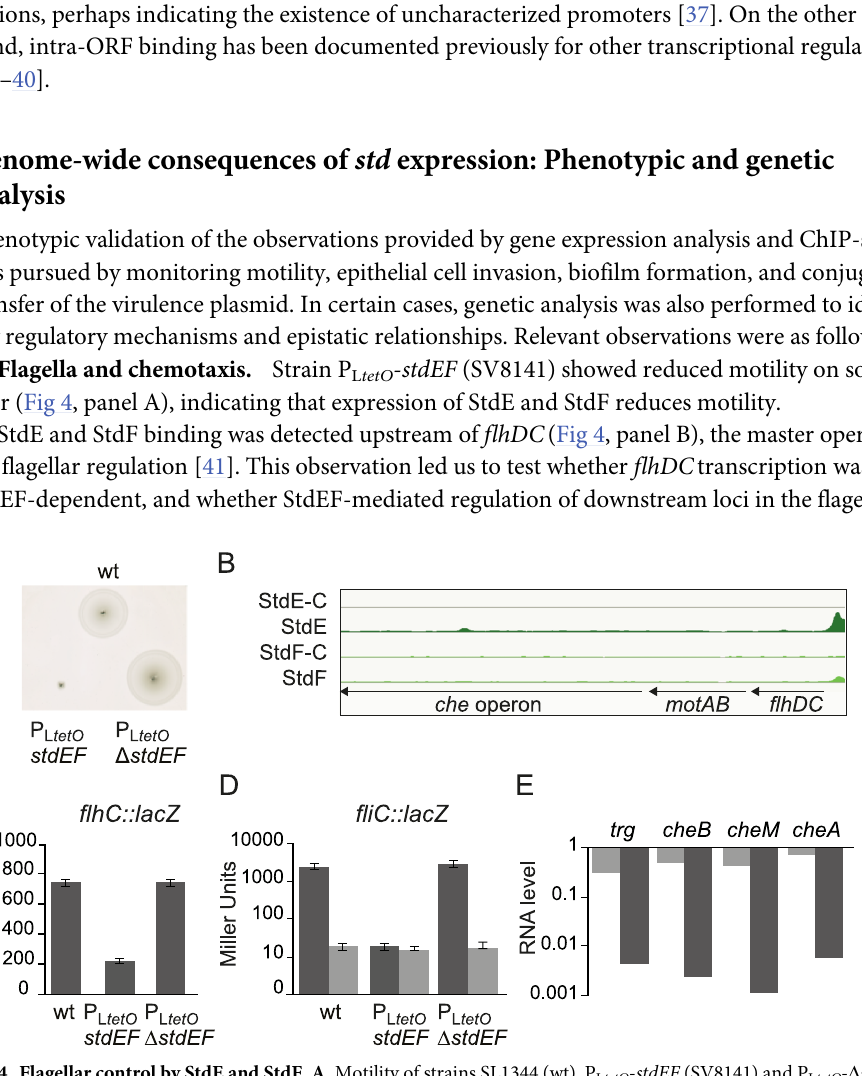
- Δ stdEF tetO - stdEF / tetO